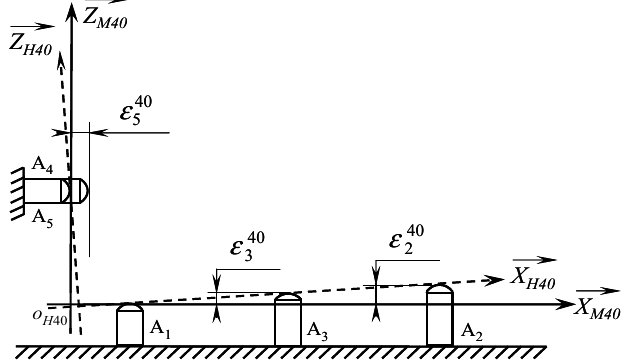
Figure 11. Deviations of the machining set-up in the phase 40.